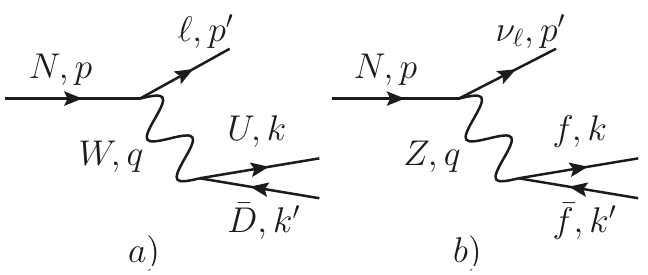
Figure 11 . Diagram for the HNL decays mediated by charged a) and neutral b)